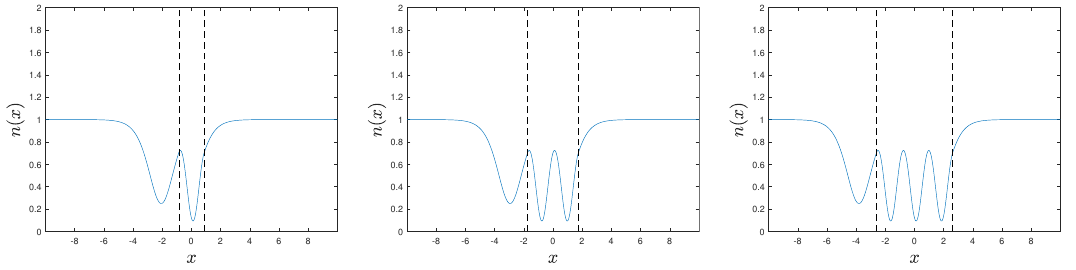
Figure 5. Density profile of the solutions containing solitons outside the square well. The vertical dashed lines mark the limits of the cavity. Upper row: m = 0,1,2 incomplete-soliton solutions for v = 0.5 and well lengths X = 1.33, X = 3.07 and X = 4.81, respectively. Central row: m = 0,1,2 complete-soliton solutions for v = 0.5 and well lengths X = 0.46, X = 1.97 and X = 3.78, respectively. Lower row: m = 1,2,3 asymmetric solutions for v = 0.5 and well lengths X = 1.74, X = 3.48 and X = 5.22,